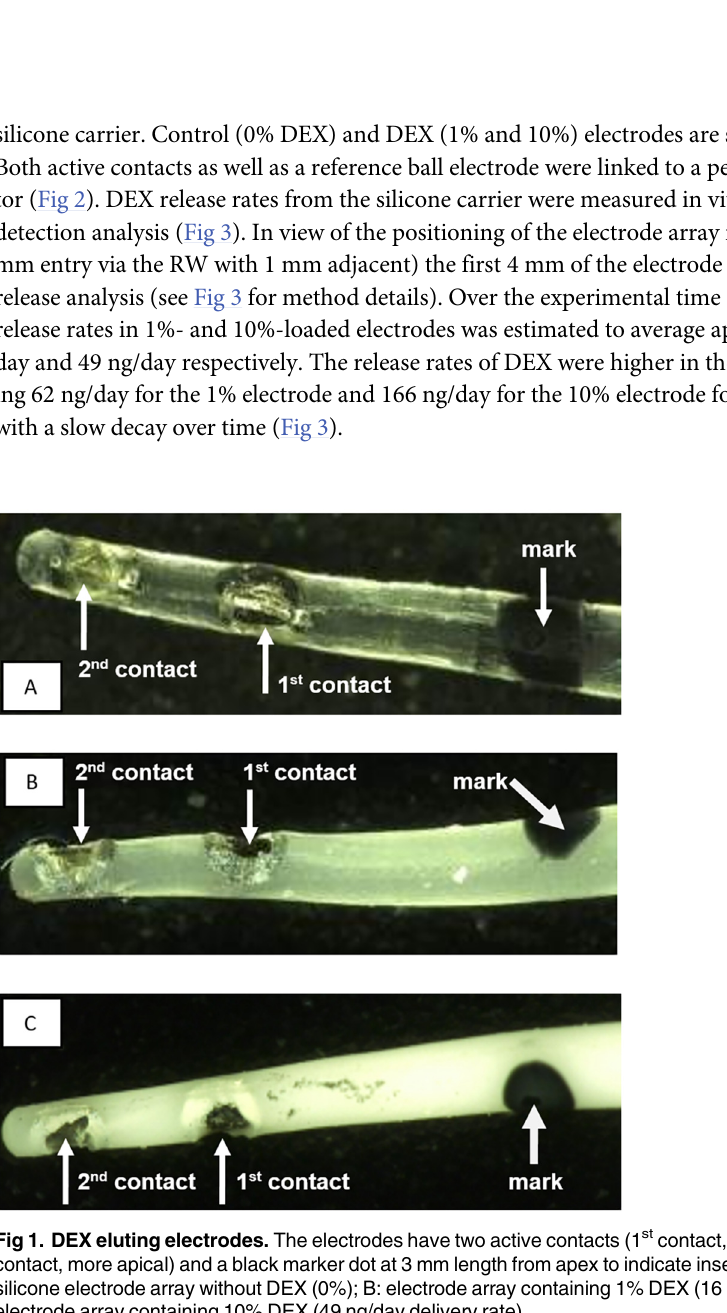
Fig 1. DEX eluting electrodes. The electrodes have two active contacts (1 st contact, more basal; 2 nd contact, more apical) and a black marker dot at 3 mm length from apex to indicate insertion depth; A: pure silicone electrode array without DEX (0%); B: electrode array containing 1% DEX (16 ng/day delivery rate); C: electrode array containing 10% DEX (49 ng/day delivery rate).